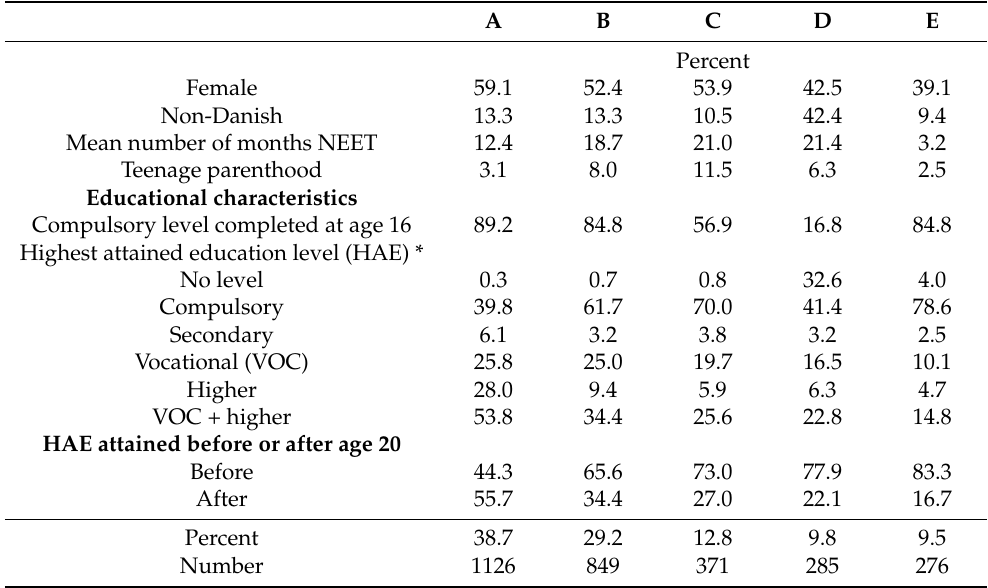
Table 1. Individual characteristics by cluster; young adults aged 16–20 with a minimum of six months